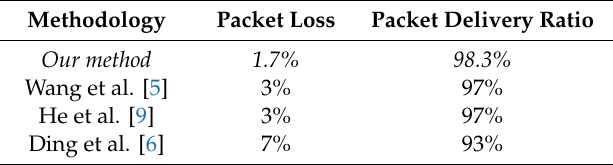
Table 3. Percentage of packet loss with 200 nodes.